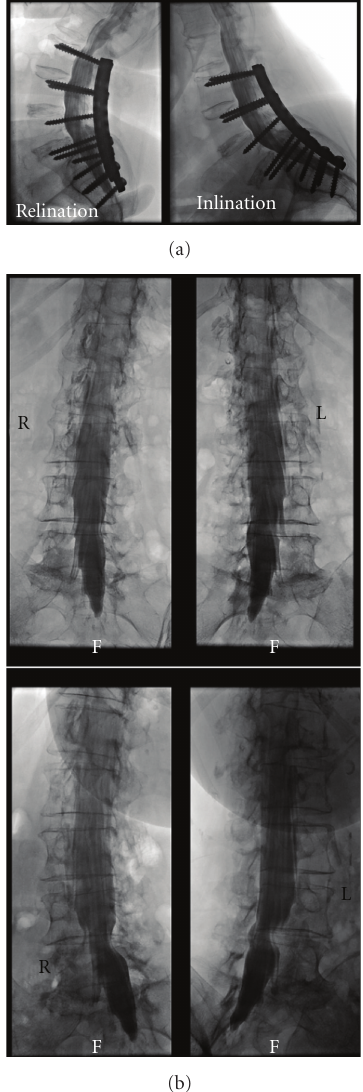
Figure 4: Diagnostic value of additional upright/functional views. (a) Extension (left) shows marked narrowing of the sagittal dural sac diameter directly above the stabilization. The finding in flexed position (right) is normal. This information cannot be obtained in the prone position alone. (b) Oblique views, top: prone position, bottom: patient standing upright. Shortening of the left L4 root and compression of the left L5 origin are only visible in the upright